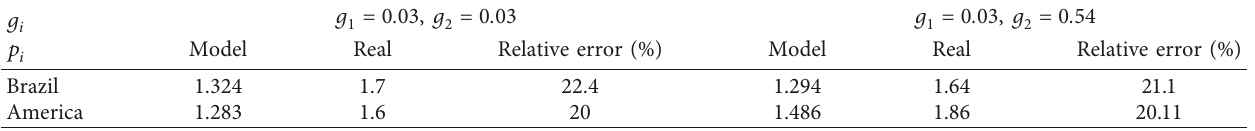
Table 4: Price prediction errors.